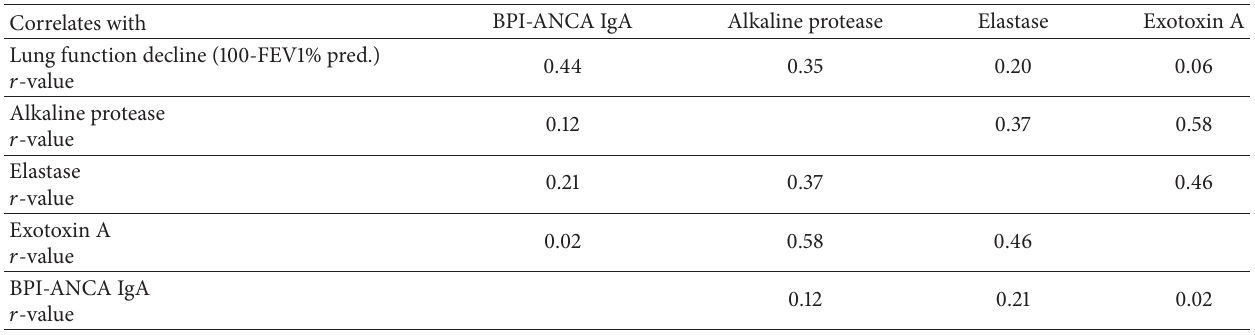
Table 3: Correlations. Patients with a chronic colonization with PsA (Leeds 1) and known lung function at inclusion ( 𝑛 = 48 ). Correlates with BPI-ANCA